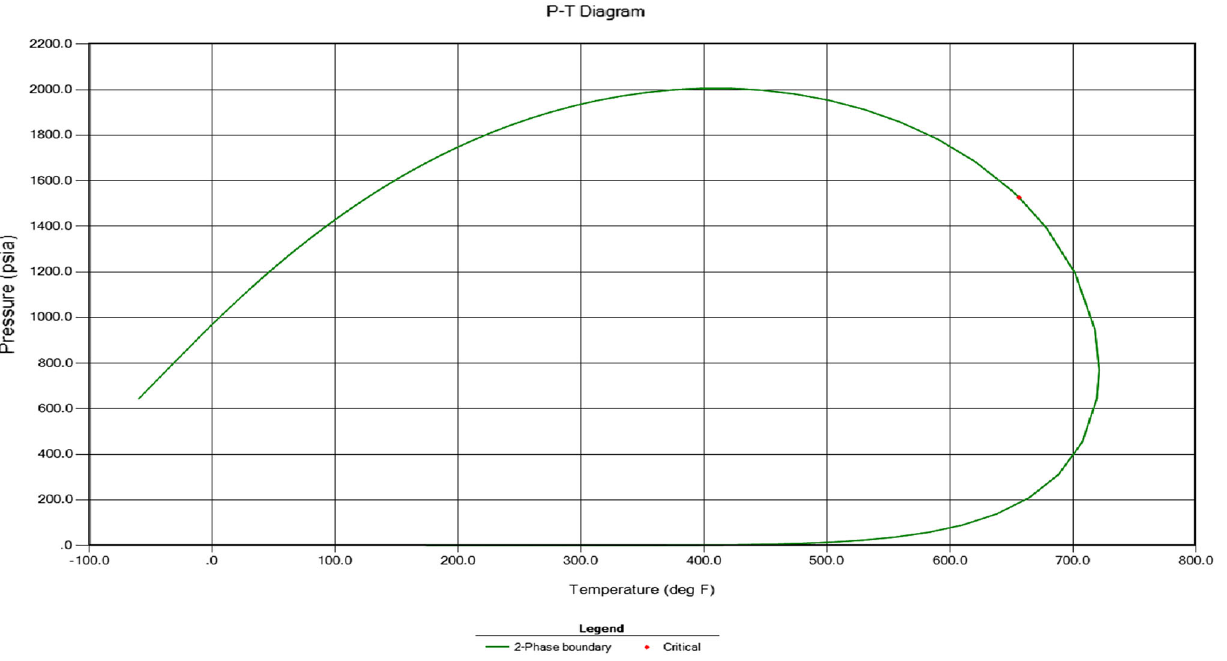
Fig. 6 Two-phase envelope for Bakken oil which was generated by WinProp-CMG